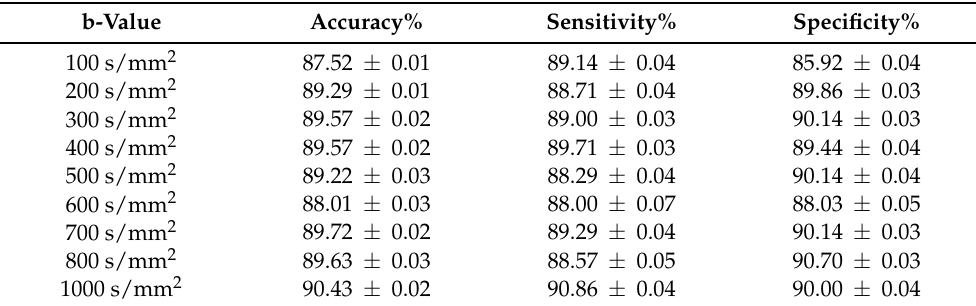
Table 4. Average Performance of AlexNet at 9 b-values using 141 randomly chosen ADC maps and repeating the experiment 10 times.